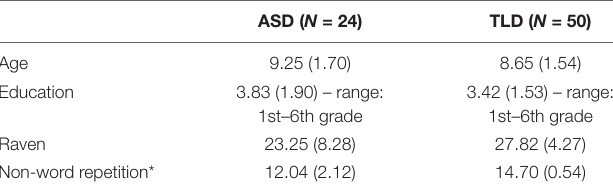
on the Non-word Repetition